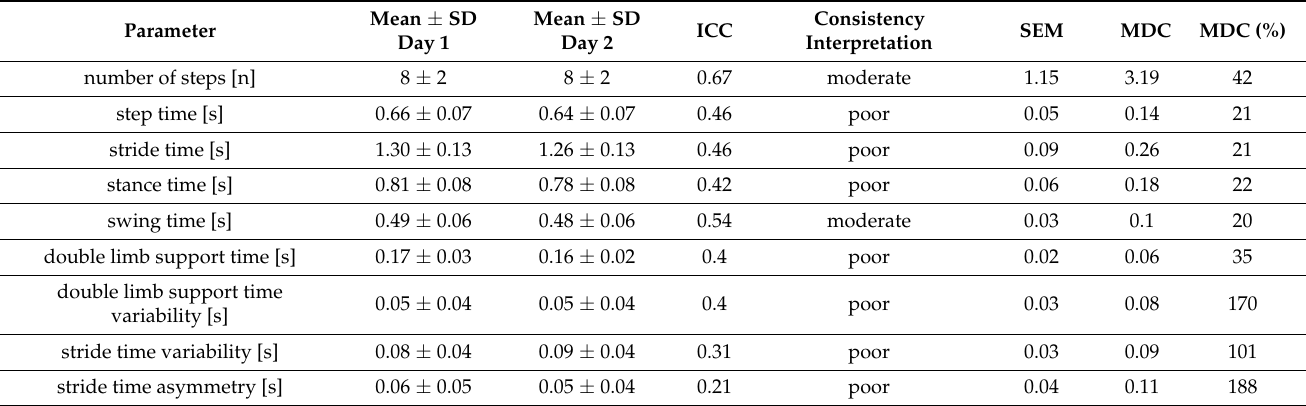
Table 1. Reliability and minimal detectable change: 4 m walking distance.